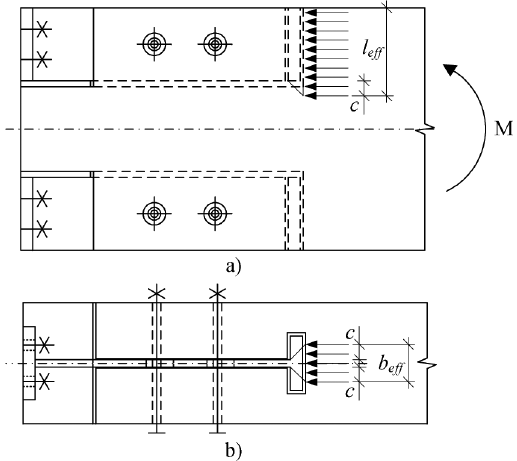
Fig. 4. The effective compressive area of timber in the tight contact with steel detail: a) front view; b) the view from top